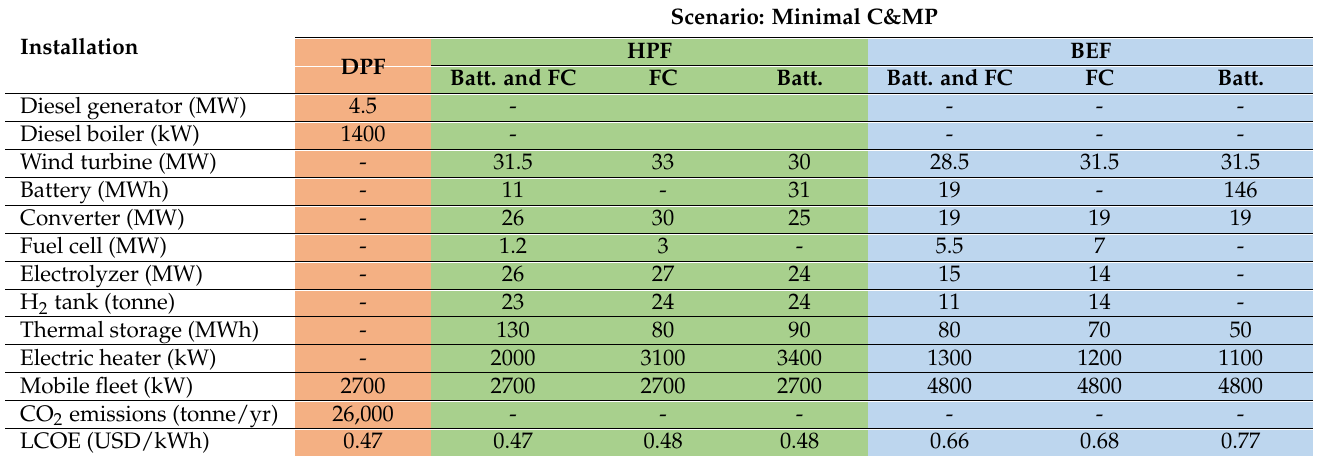
Table 3. Installation capacities and economic–environmental results for minimal C&MP scenario in 5 MW modular size scale.